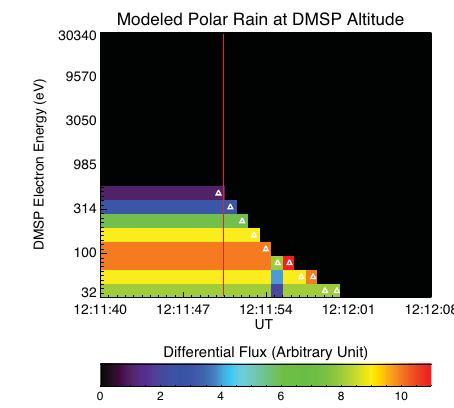
Figure 2. Polar rain electron dispersion from the APL-OPM model calculation. The electron spectra between 12:11:40 and 12:11:49UT represent the typical polar rain. There is a clear elec- tron energy-latitude dispersion after 12:11:49UT. The white trian- gles, which indicate the highest energy detected at a given latitude, give a measure of the energy-latitude dispersion. They are used to determine the electron path lengths between DMSP altitude and magnetotail reconnection site. The vertical red line marks the lo- cation of the highest energy polar rain electrons in the dispersion